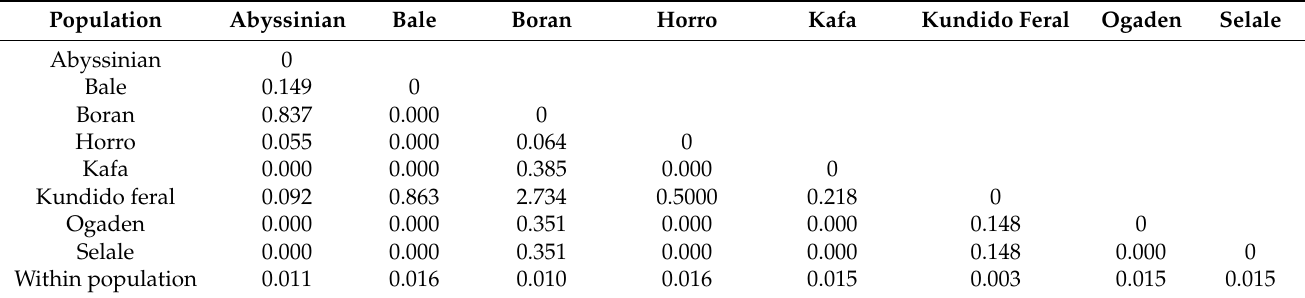
Table 4. Matrix of Slatkin’s linearized genetic distances ( F ST ) between native Ethiopian horse populations. Population